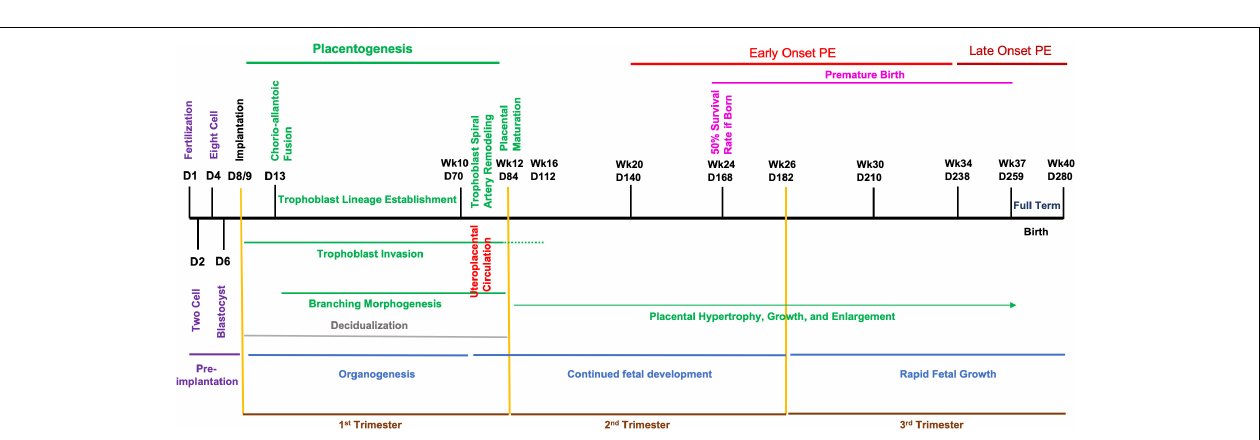
FIGURE 2 | Developmental timeline of human pregnancy. Graphical chronology of events associated with placental and fetal development in humans (Benirschke et al., 2012; Soncin et al., 2015; Sones and Davisson, 2016; Blum et al., 2017). Days of development are denoted as day of development (D) and week of development